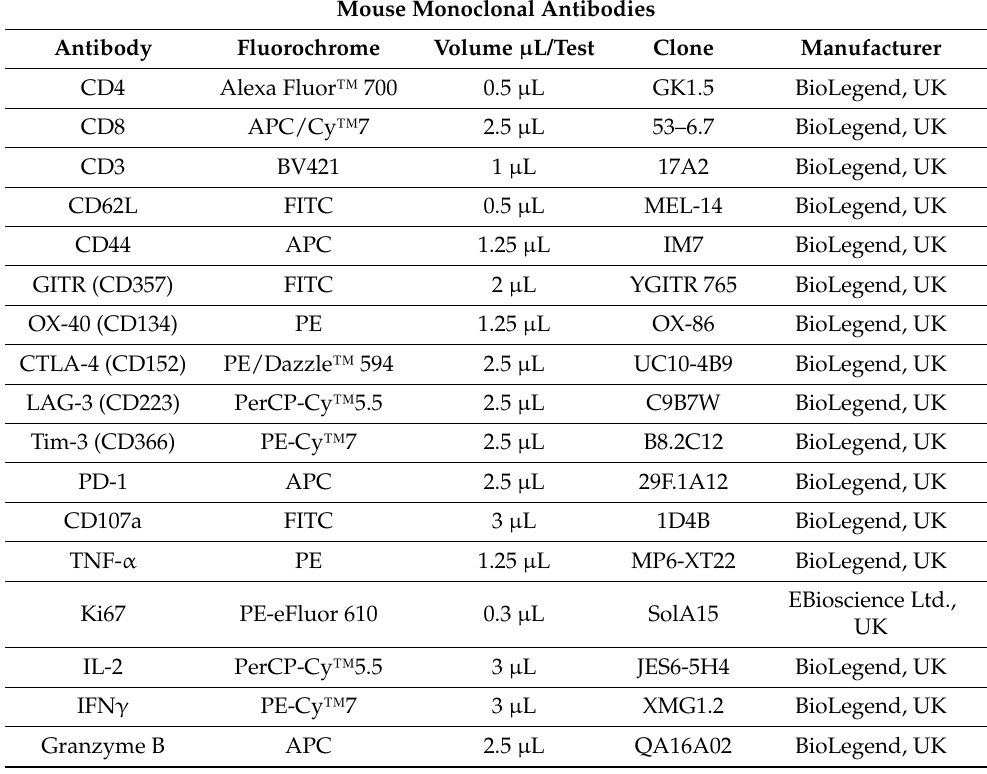
Table A1. List of murine monoclonal antibodies.